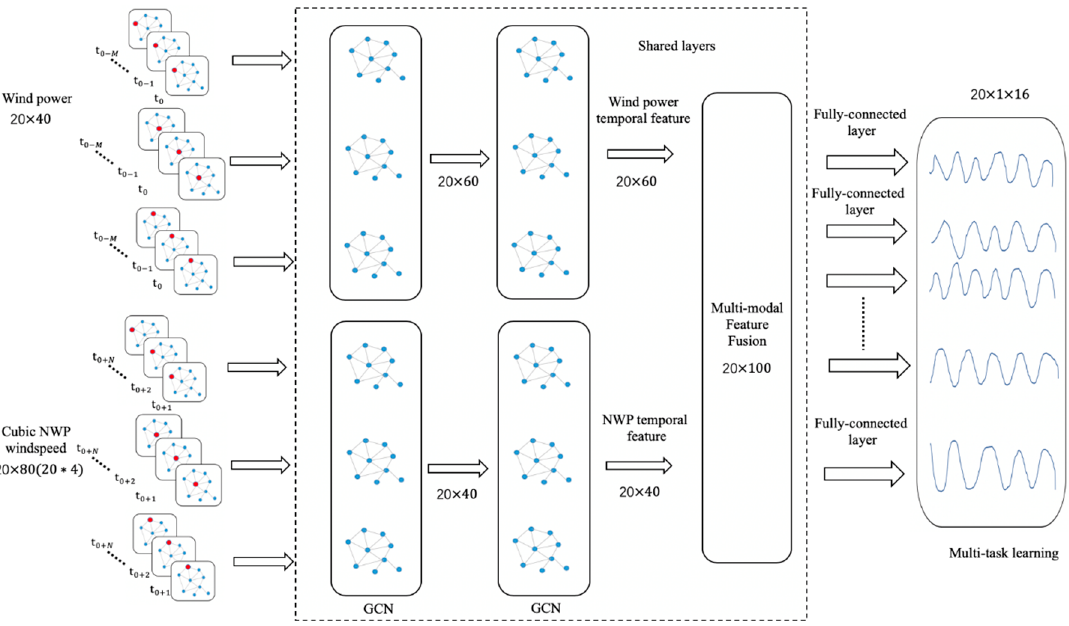
Figure 5. Multi-modal multi-task graph spatiotemporal network (M2GSNet) model for wind farm cluster power prediction.